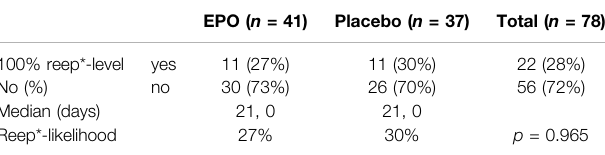
TABLE 8 | Likelihood of achieving the designated re-epithelialization levels within the observation period by subgroup